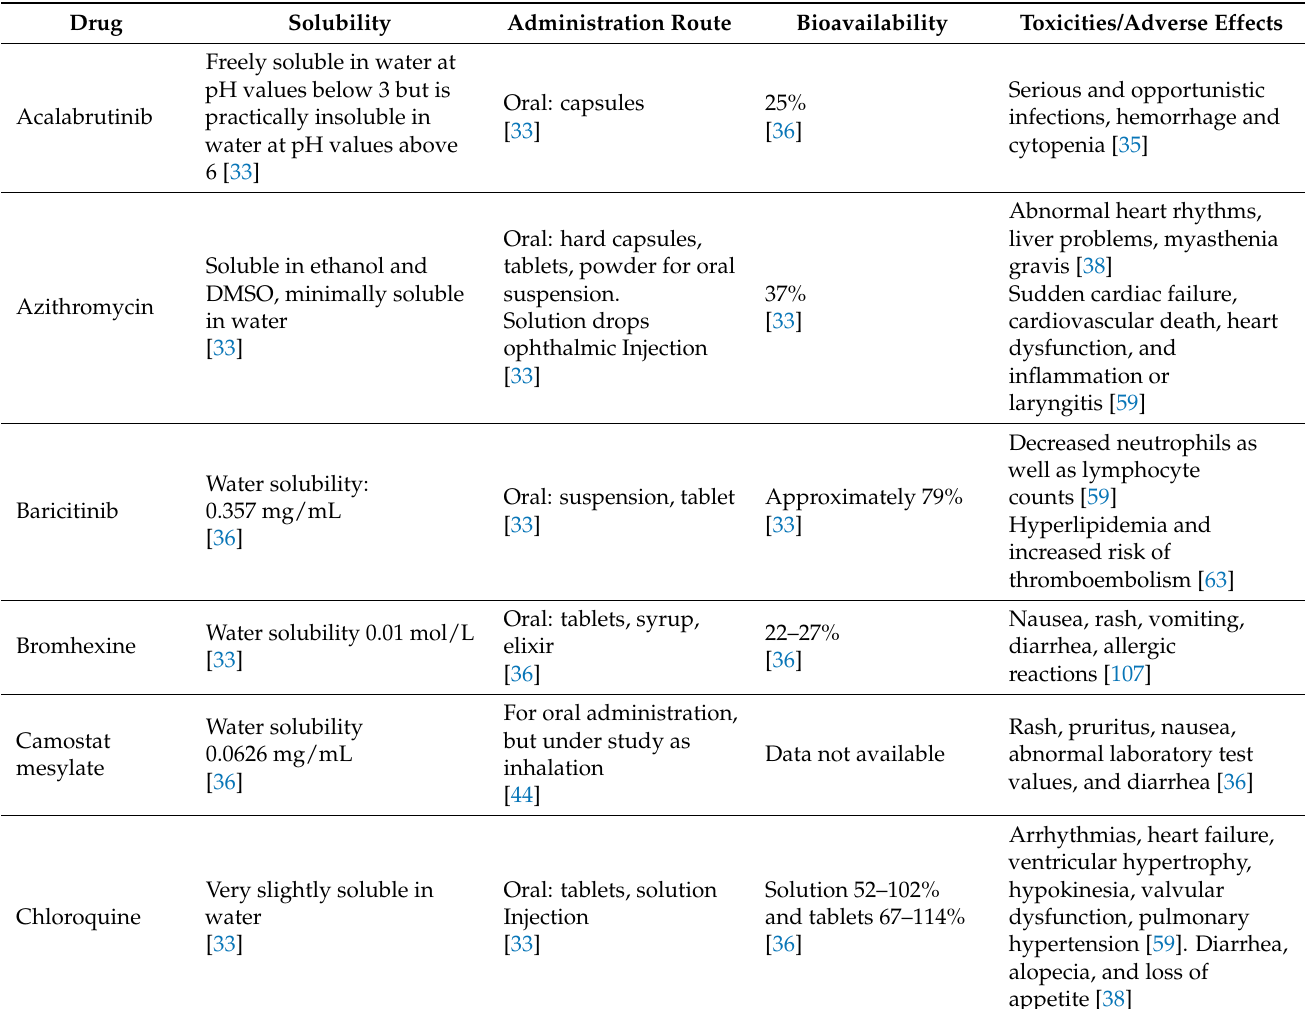
Table 2. Drugs against COVID-19 infection, characteristics related to solubility, administration route, bioavailability and toxicities/adverse